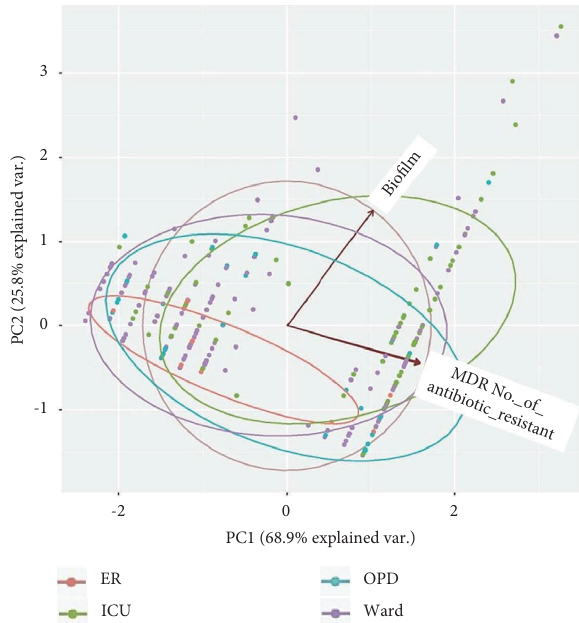
Figure 2: Principal component analysis (PCA) among isolates’ origin, Bioflm formation, MDR, and a number of antibiotic resistance.